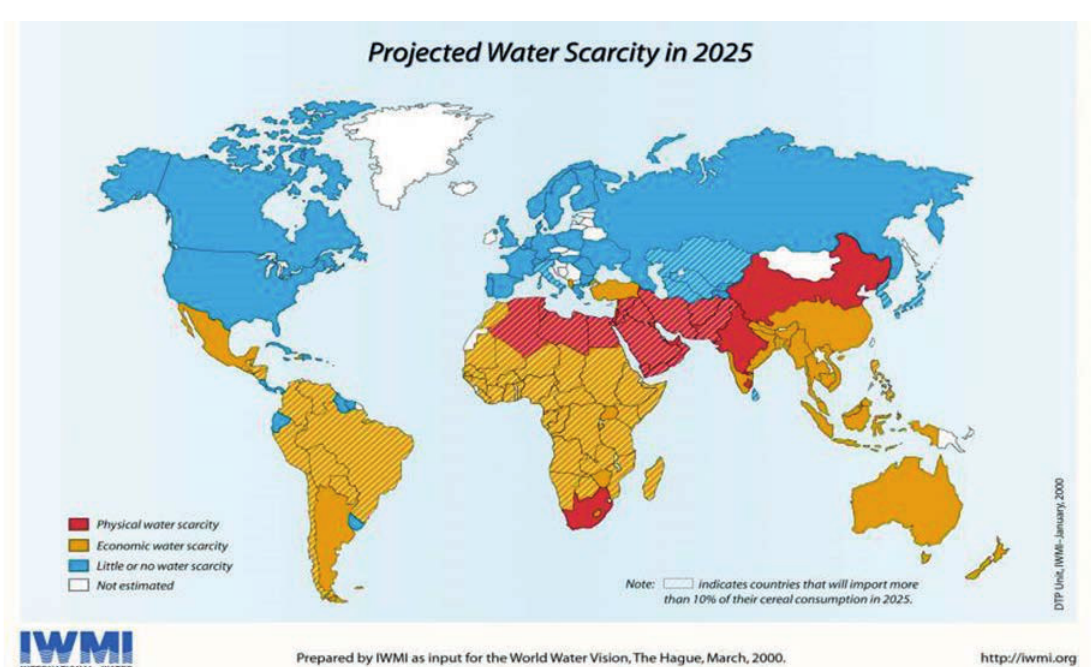
Fig. 3 Projected water scarcity in 2015, worldwide by